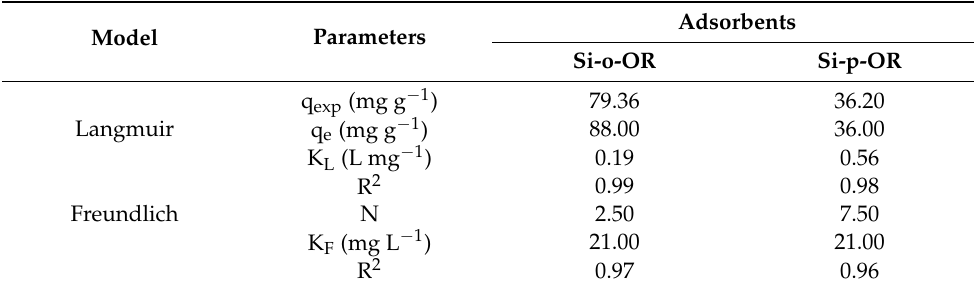
Table 2. Parameters for the Langmuir and Freundlich models of Cu(II) sorption.